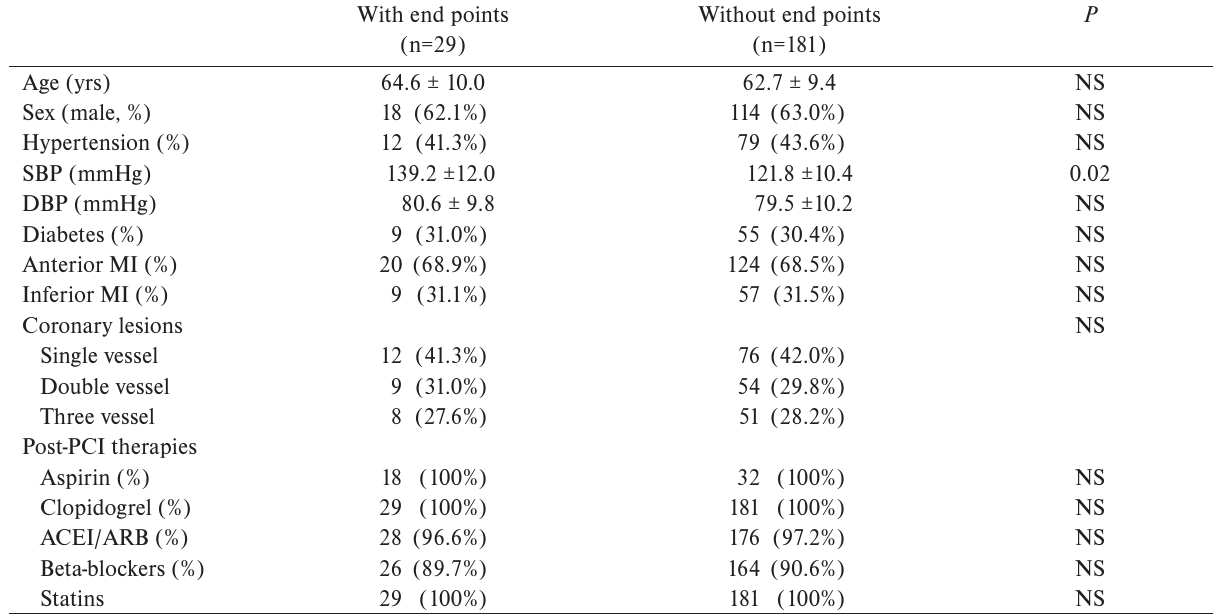
Table 1. Comparison of baseline characteristics.